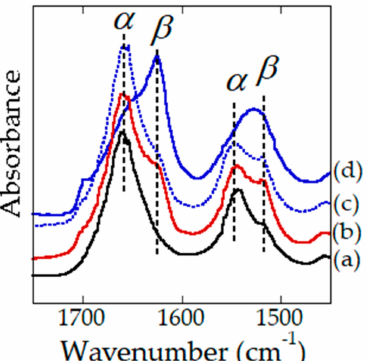
Figure 2. FTIR spectra of films cast from silk fibroin (SF) solutions obtained by dissolution of 40%-EtOH-solidified Bombyx mori ( B. mori ) SGF for 10 days (spectrum d ) and 90 days (spectrum c ), and S. c. ricini SGF for 12 h in HFIP (spectrum b ) at 23 ± 2 ◦ C. Spectrum ( a ) is that of the film cast from an aqueous solution of S. c. ricini LF.